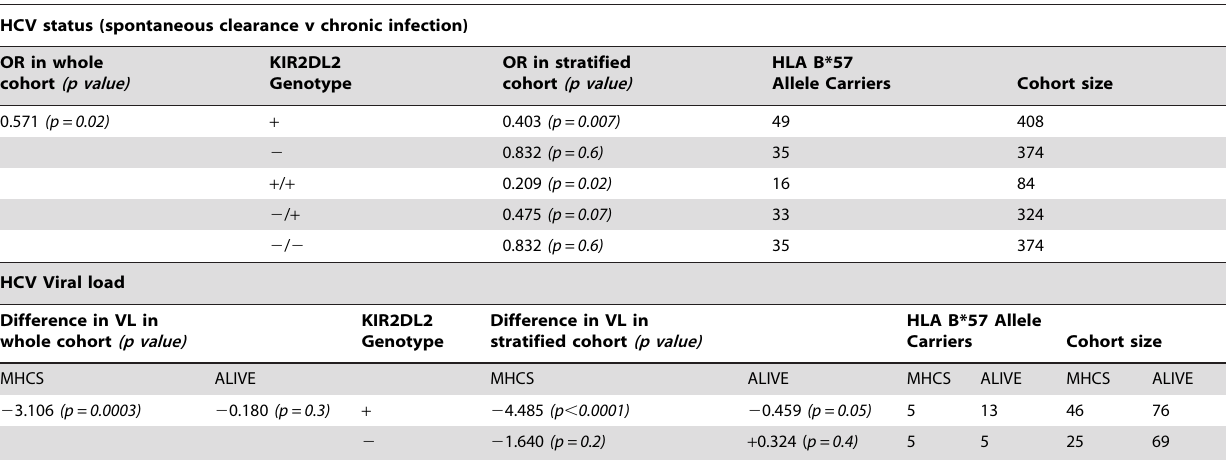
Table 2. KIR2DL2 in HCV infection: KIR2DL2 enhances the protective effect of HLA-B*57 on HCV status (spontaneous clearance v chronic infection) and, independently, on HCV viral